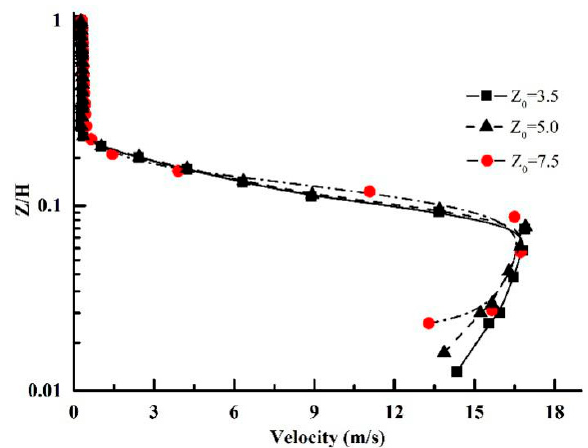
Figure 9. The vertical velocity at position [x = 1.4, y = 0, z = − 0.3] of the smooth spillway for z 0 = 3.5, z 0 = 5.0, and z 0 =